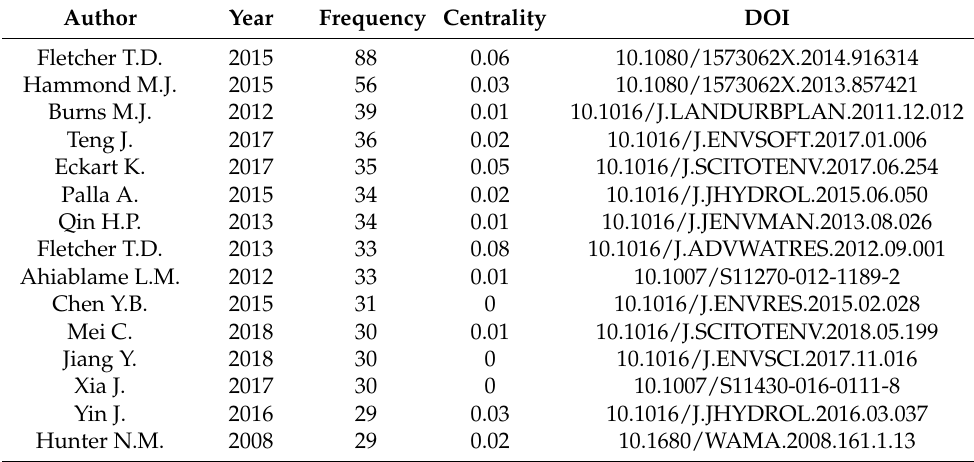
Table 3. Details of the top 15 highly co-cited